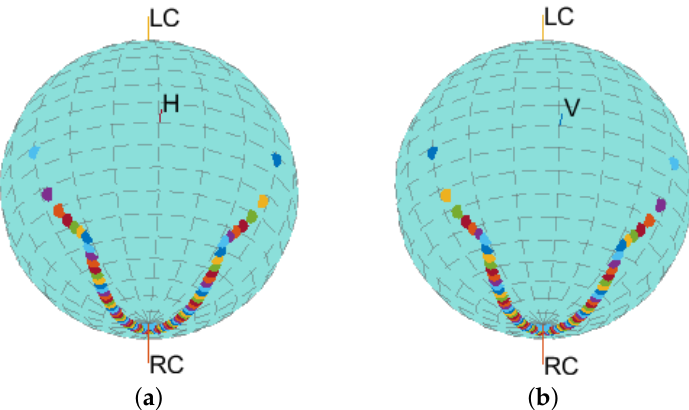
Figure 6. Polarization states distribution on the Poincaré sphere in different directions. ( a ) along with the azimuth angle when θ = 60 ◦ ; ( b ) along with the elevation angle φ = − 30 ◦